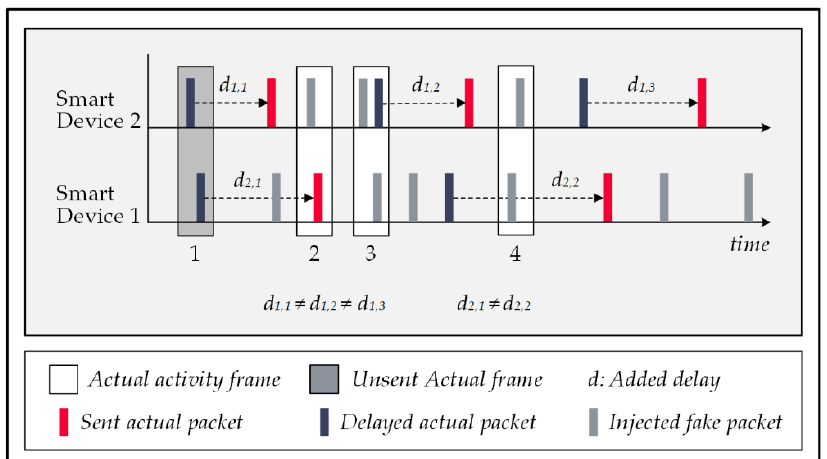
Figure 9. A hybrid of temporal manipulation and fake packet injection techniques.